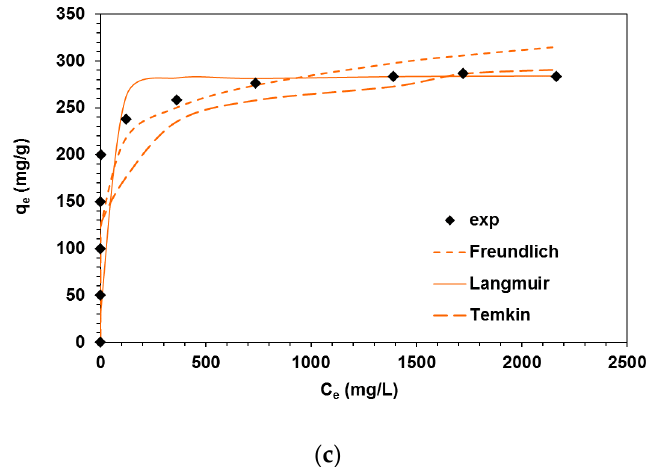
Figure 2. Equilibrium adsorption data with fitting curves corresponding to the Freundlich, Langmuir and Temkin models for ( a ) DB22, ( b ) DR23 and ( c ) DO26 adsorption on A21 resin. The maximum adsorption capacity of the weakly basic anion exchange resin A21 for DO26, DR23 and DR22 determined in our studies (Table 2) was compared with the literature values for other adsorbents (Table 3). It can be concluded that the A21 resin has good adsorptive potential to remove direct dyes such as Orange 26, Red 23 and Black 22 from aqueous solutions. Table 3. Screening of adsorbents applied for DO26, DR23 and DB22 removal using different types of adsorbents.